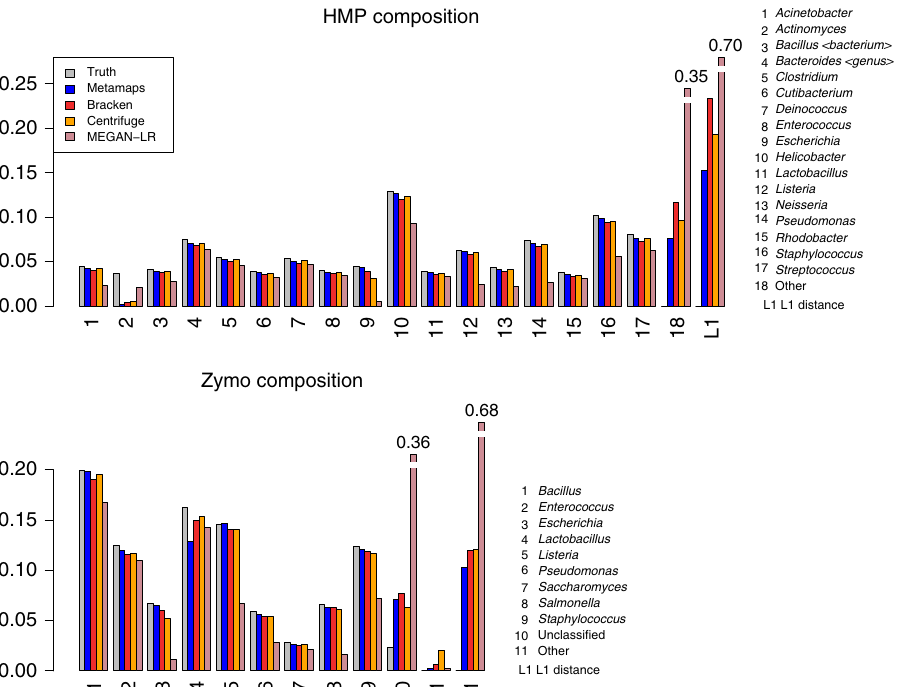
Fig. 5 Compositional estimation in the HMP7 and Zymo experiment at the genus level. The fi gure shows the compositions inferred by MetaMaps, Centrifuge, Bracken, LAST + MEGAN-LR, and the assumed true composition. The L1 bar shows the combined L1 distance between the inferred and the true compositions. Note that the Acinetobacter , Actinomyces , and Rhodobacter genomes present in the HMP7 sequencing sample are not part of the database; reads classi fi ed as belonging to these genera map to other genomes of the same species/genus (see “ Evaluating HMP7 performance ” in Materials and methods). All but one fungal species ( Cryptococcus neoformans ) present in the Zymo sample are represented in the